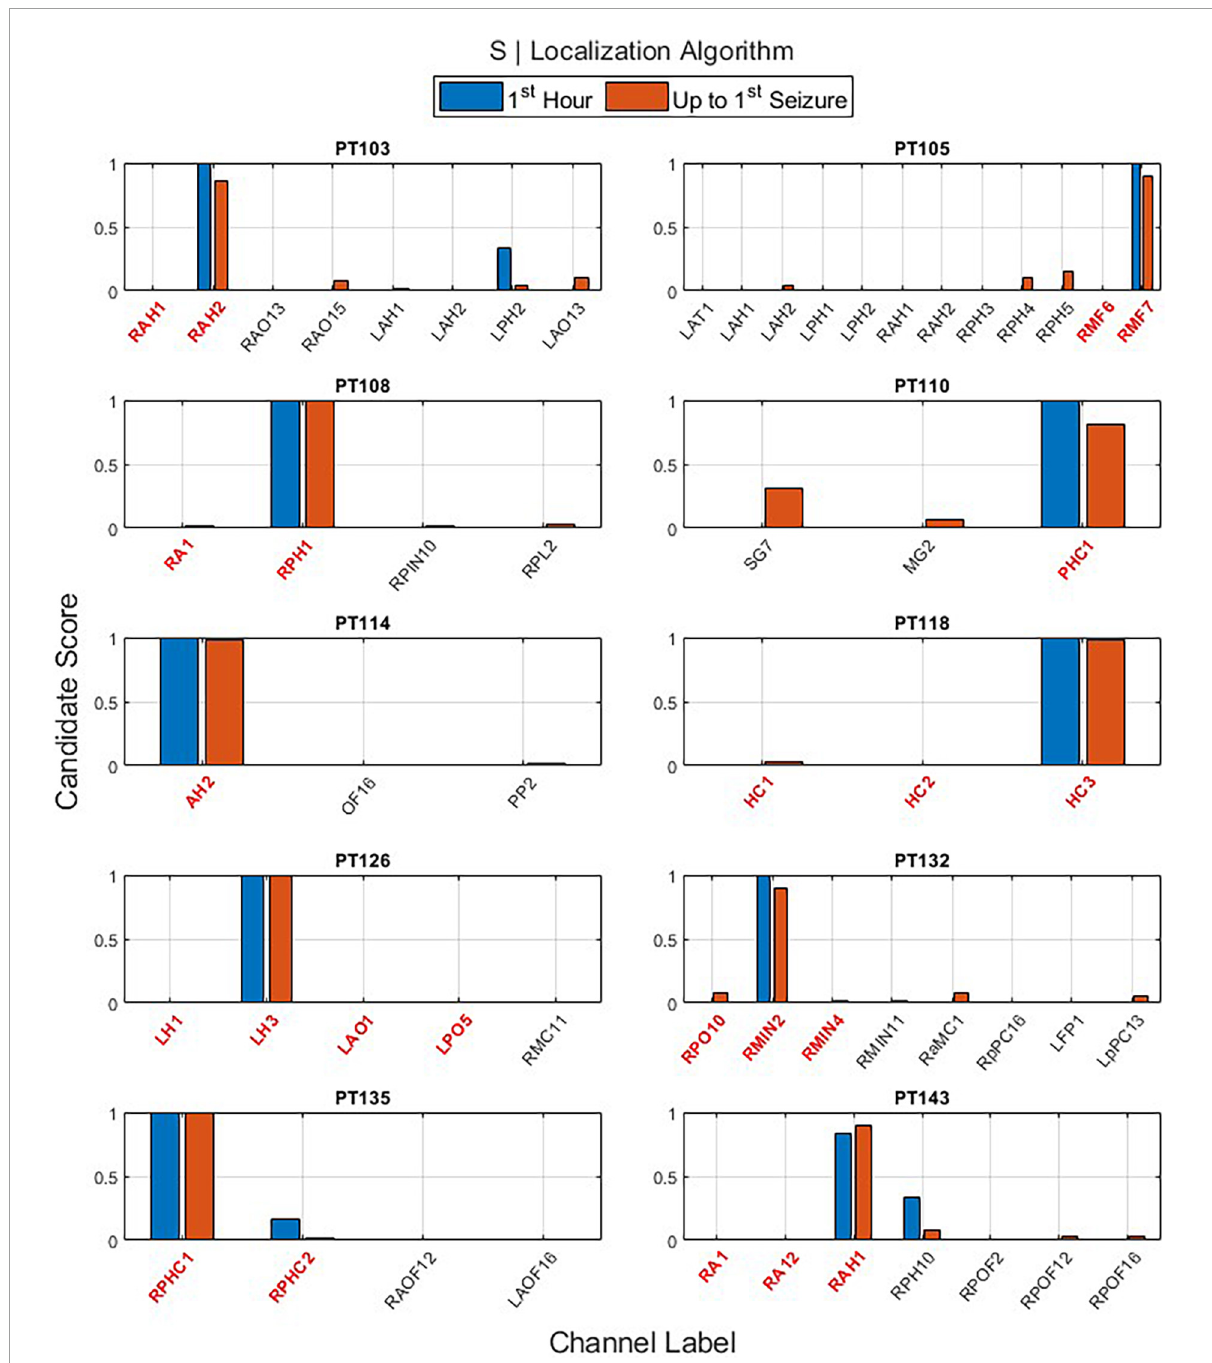
FIGURE6 The output of the EZ interictal localization algorithm (EZILA) per the (10th) patient via the periodogram ( S ) measure when applied at two time periods: first hour (blue) and up-to-first seizure (brown). Red tick(s) in the channel label axis denote clinically assessed focal channel(s). EZILA was successful in assigning the highest candidate score to one of the clinically assessed focal channel in all the 10 patients at both time periods. Legends: RAH, right anterior hippocampus; RPH/RPHC, right posterior hippocampus; LAH, left anterior hippocampus; LPH, left posterior hippocampus; RAO/RAOF, right anterior orbitofrontal; RPO/RPOF, right posterior orbitofrontal; LAO/LAOF, left anterior orbitofrontal; LPO/LPOF, left posterior orbitofrontal; LAT, left anterior temporal; RMF, right mesial frontal; RA, right amygdala; RPIN, right posterior insula; RPL, right posterior lesion; SG, left temporal Spencer grid; MG, minigrid; PHC, parahippocampus strip; AH, anterior hippocampus; OF, orbitofrontal; PP, posterior parietal; HC, hippocampus; RMC, right mesial cingulate; RMIN, right mesial insula; RaMC, right anterior mid cingulate; RpPC, right posterior posterior cingulate; LFP, left frontal pole; LpPC, left posterior posterior cingulate; AMG, amygdala; LH, left